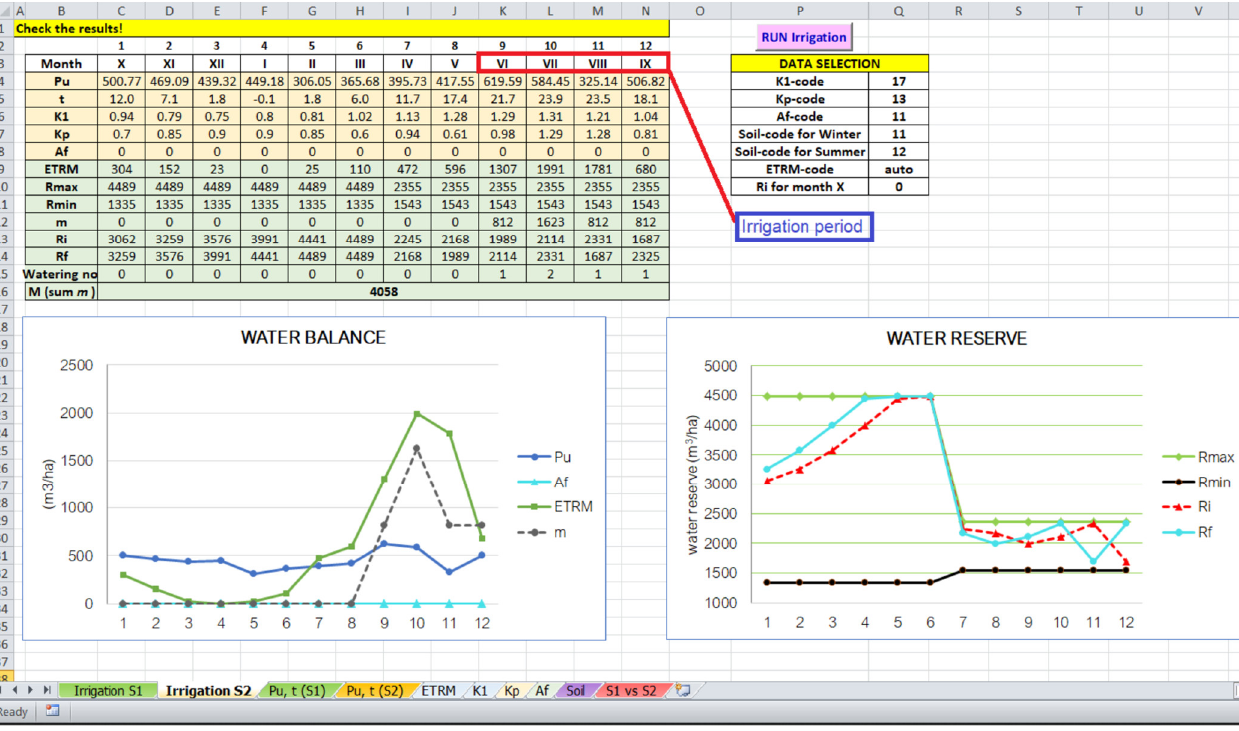
Figure 14. Comparison of the results for CT and TL (from the worksheet “S1 vs. S2”). The ETRMs are comparable at CT and TL. The initial and final water reserve is slightly higher at TL. The irrigation rate is the same at TL and CT. The watering should be applied the same month and in the same amount. From Figures 12 – 14, row 30, it results that during the first eight months of the agri- cultural year (October – May), it is not necessary to apply irrigation. In June, August, and